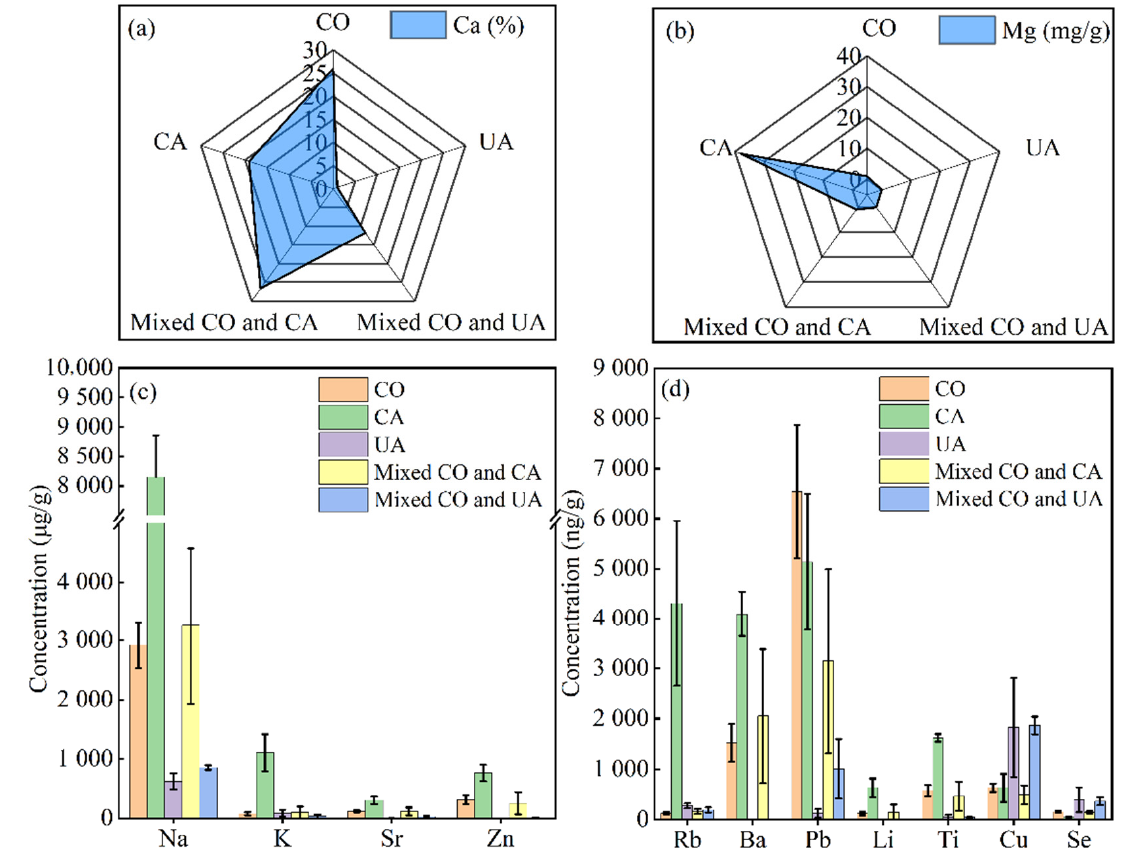
Figure 1. The content of elements in the kidney stones: ( a ) Ca content; ( b ) Mg content; ( c ) major element content (Na, K, Sr, and Zn), and ( d ) trace element content (Rb, Ba, Pb, Li, Ti, Cu, and Se).